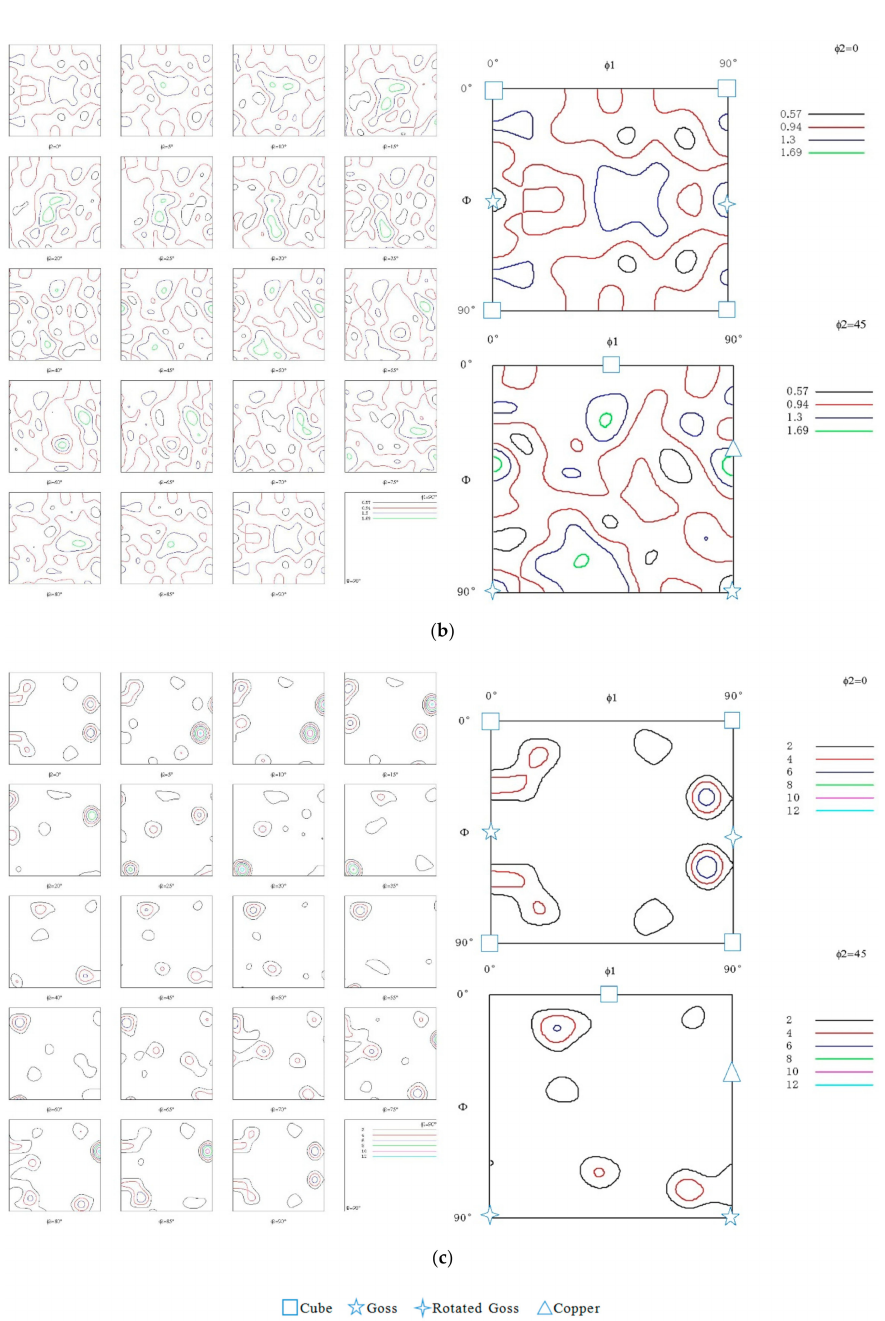
Figure 10. ODF cross-sectional views of a 5056 aluminum alloy after annealing at different tempera- tures ( a ) cold drawing; ( b ) 400 ◦ C; ( c ) 560 ◦